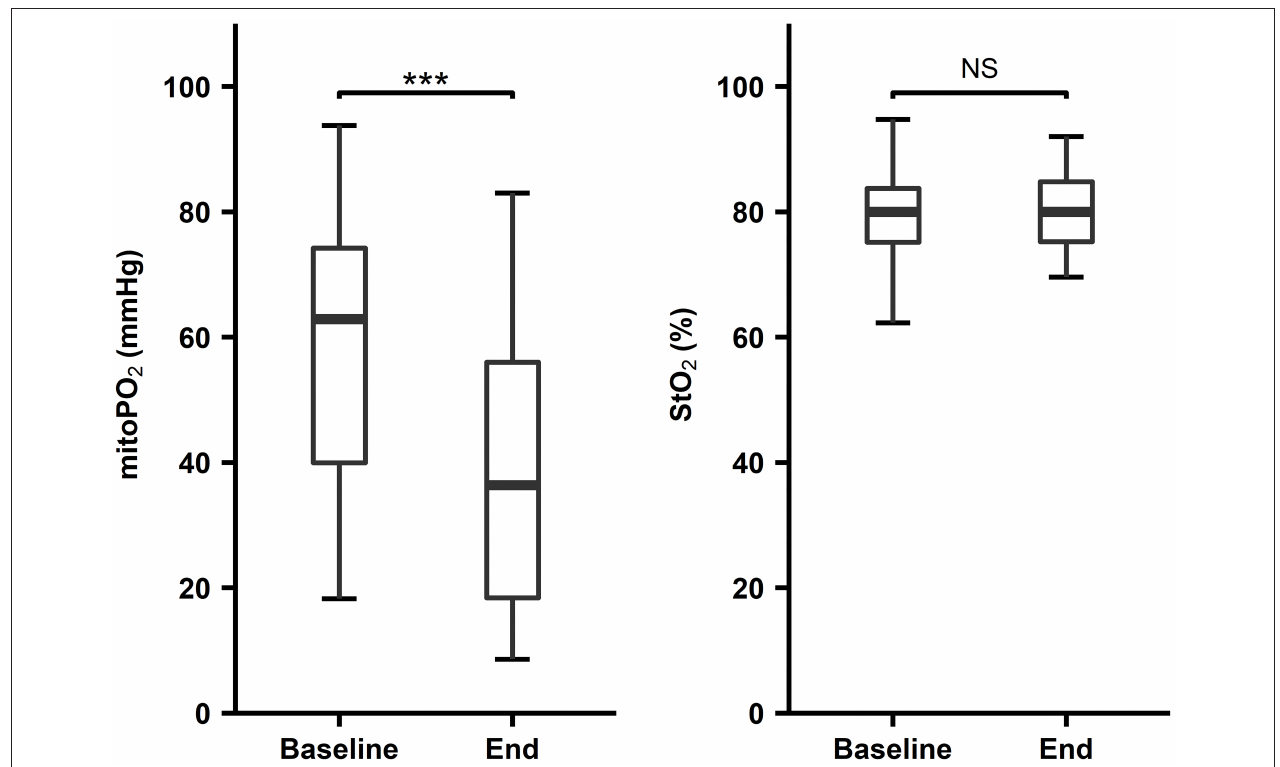
FIGURE 3 | First and last four values during CPB, COMET ® cutaneous mitoPO 2 n = 41, *** p < 0.01, INVOS ® StO 2 , n = 31, p = not significant (NS). Boxplot with median, IQR box, and whisker 1.5 times IQR.